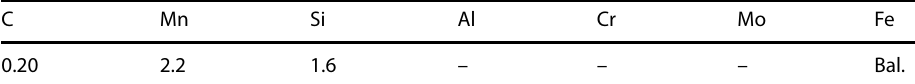
Table 1 Chemical composition (wt%) of examined